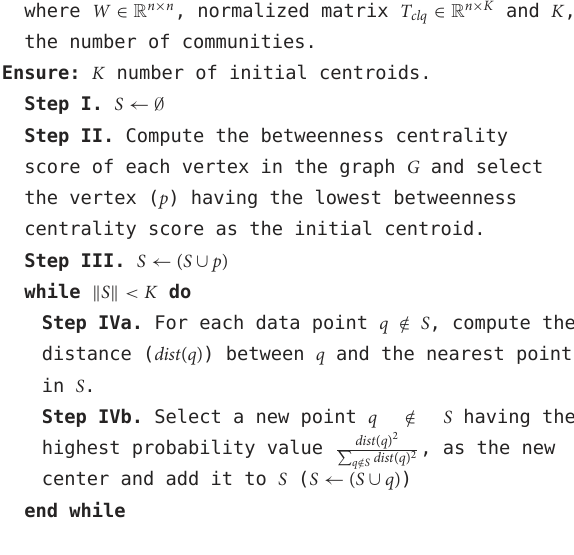
Algorithm 2. Initial centroids selection